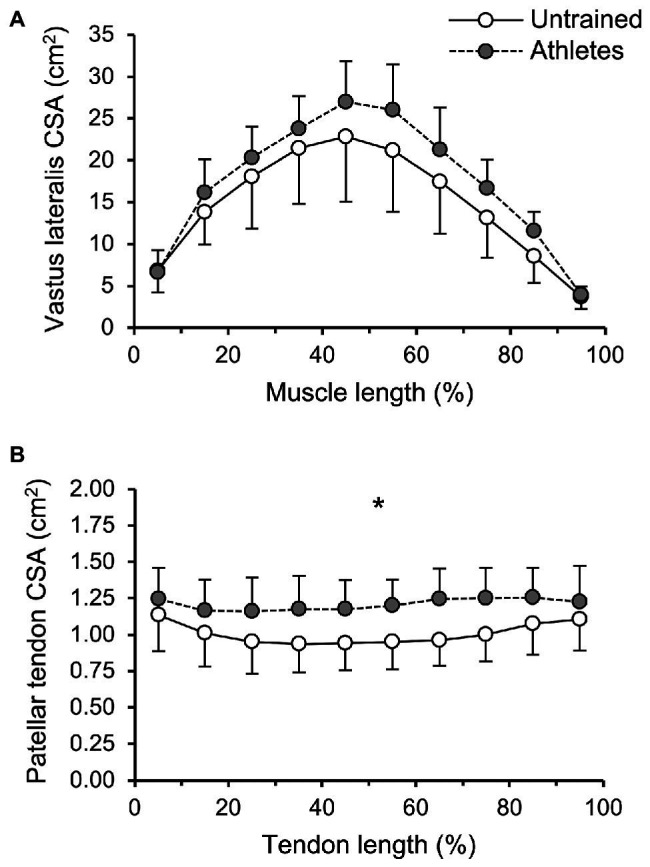
(A) Vastus lateralis (VL) anatomical cross-sectional area and (B) patellar tendon cross-sectional area (CSA) of adolescent athletes (gray; n = 14) and untrained controls (white; n = 10) as a function of muscle or tendon length. The values represent average values ± SD of 10%-intervals (i.e., 0–10%, …), respectively. Note that body mass was used as covariate in the statistical analysis. *Significant main effect of group (p < 0.05).